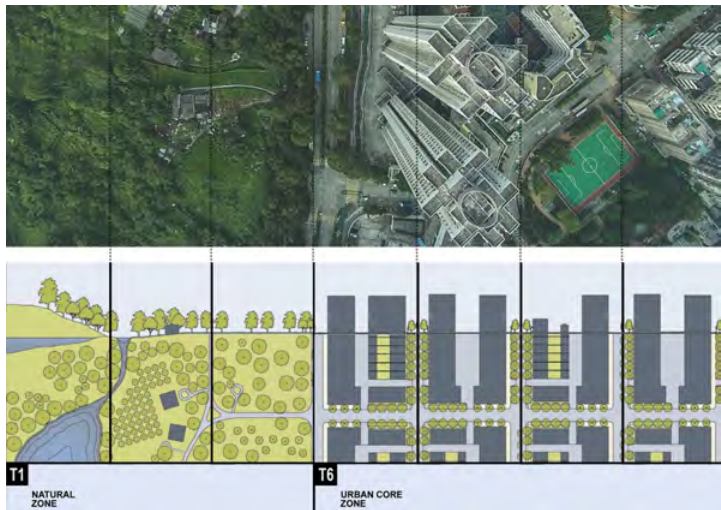
Figure 2. Indistinctive zone type of urban core zone